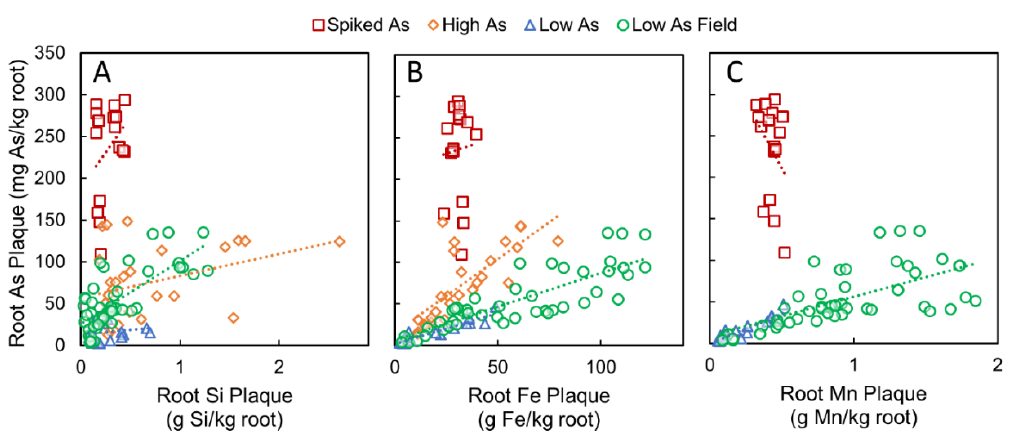
Figure 4. Relations between DCB-extractable As (i.e., plaque As) and ( A ) plaque Si, ( B ) plaque Fe, and ( C ) plaque Mn. Root plaque As was most positively correlated to plaque Fe, but was also positively correlated to plaque Si and Mn for most studies.